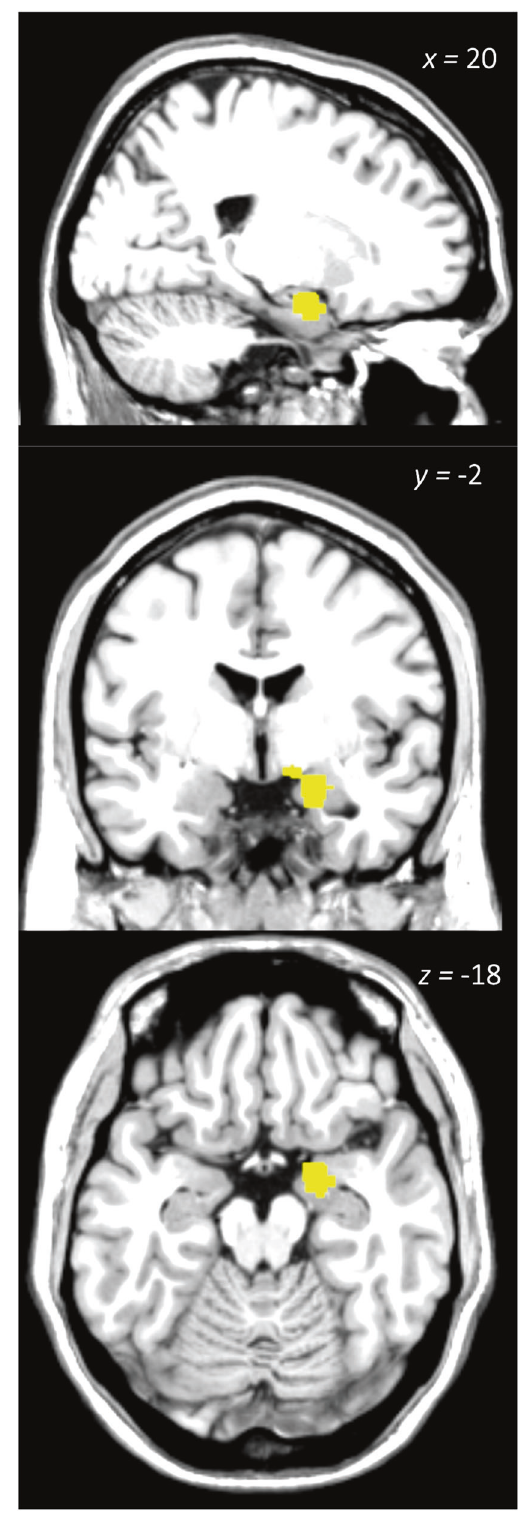
Fig. 2 Neural correlate of pain with concomitant depression. Right parahippocampal gyrus/amygdala signi fi cantly associated with depression scores in pain